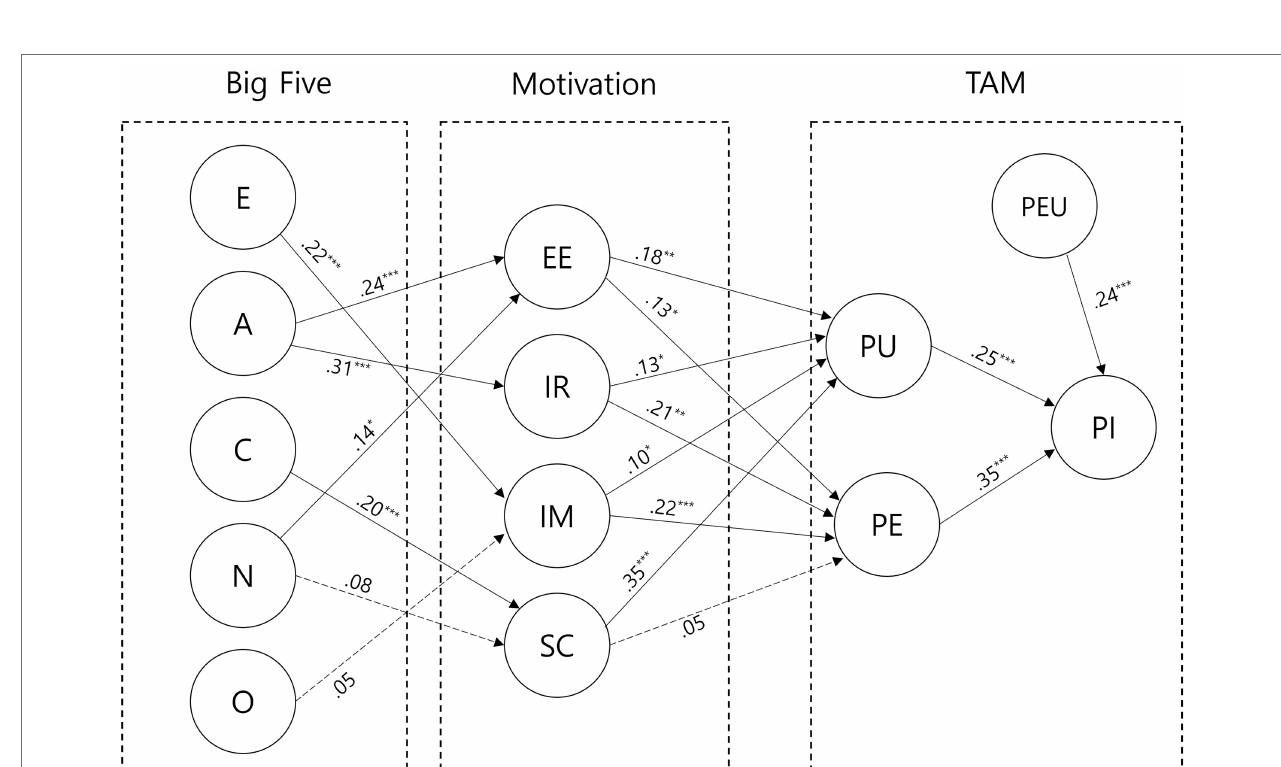
FIGURE 3 | Model results. * p < 0.05; ** p < 0.01; *** p <